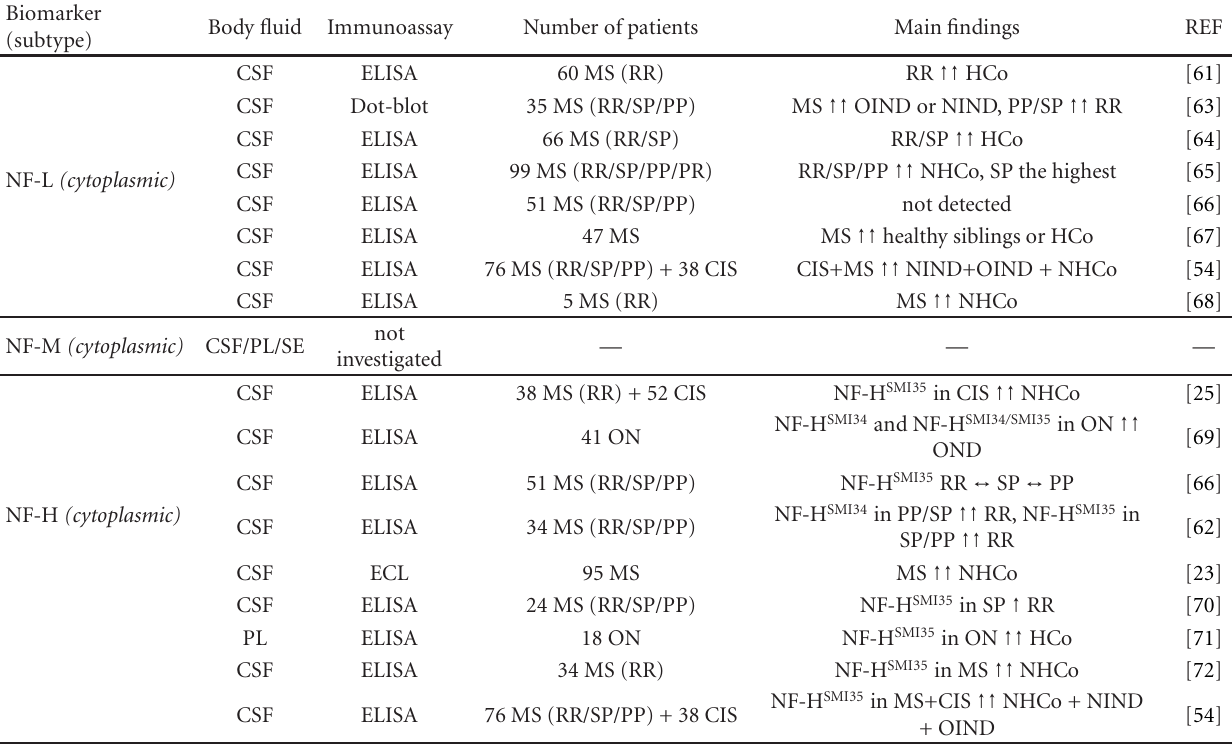
Table 1: Neurofilament subunits in the cerebrospinal fluid (CSF) and blood of patients with multiple sclerosis(MS) and/or clinically isolated syndrome suggestive of MS